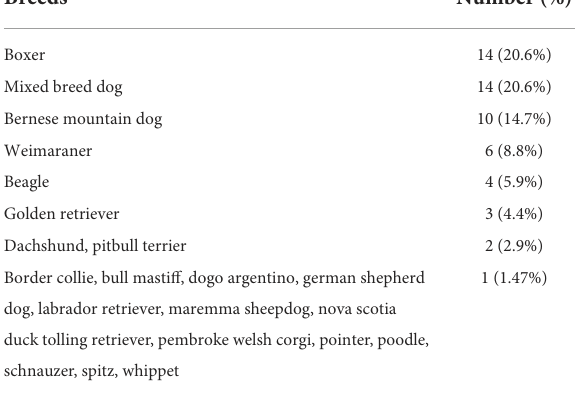
TABLE 2 Breeds included in the study.